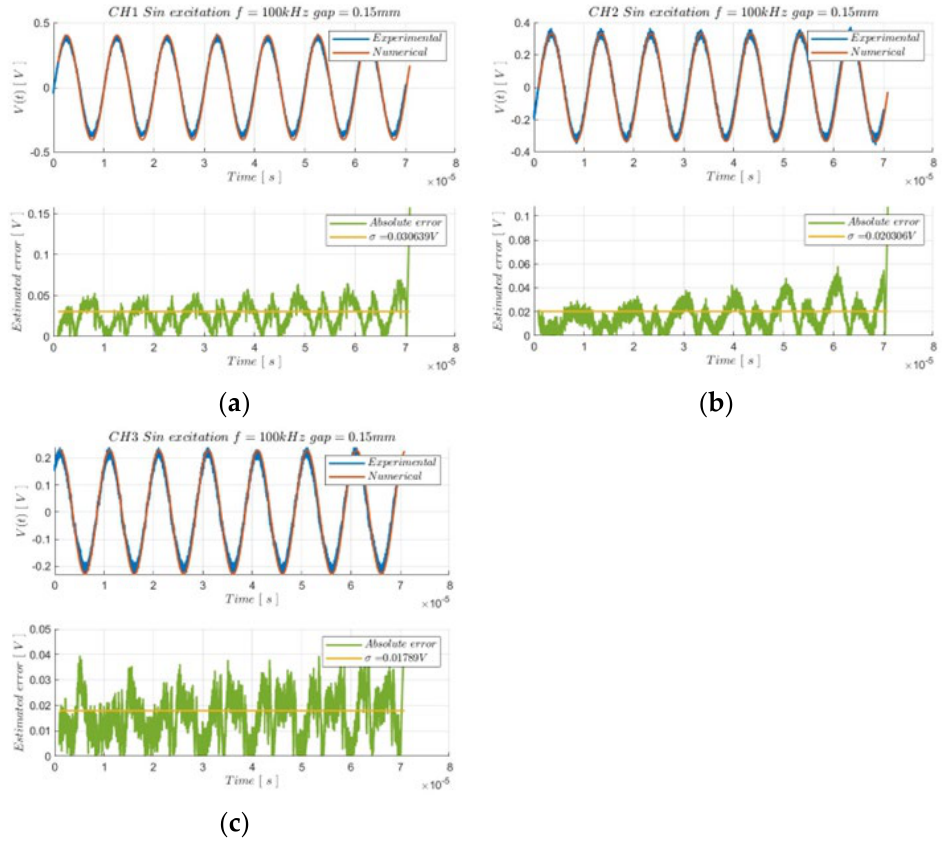
time window; ( b ) CH2 signal comparison on a time window. 7 𝜋𝜋𝑐𝑐 7 𝜋𝜋𝑐𝑐